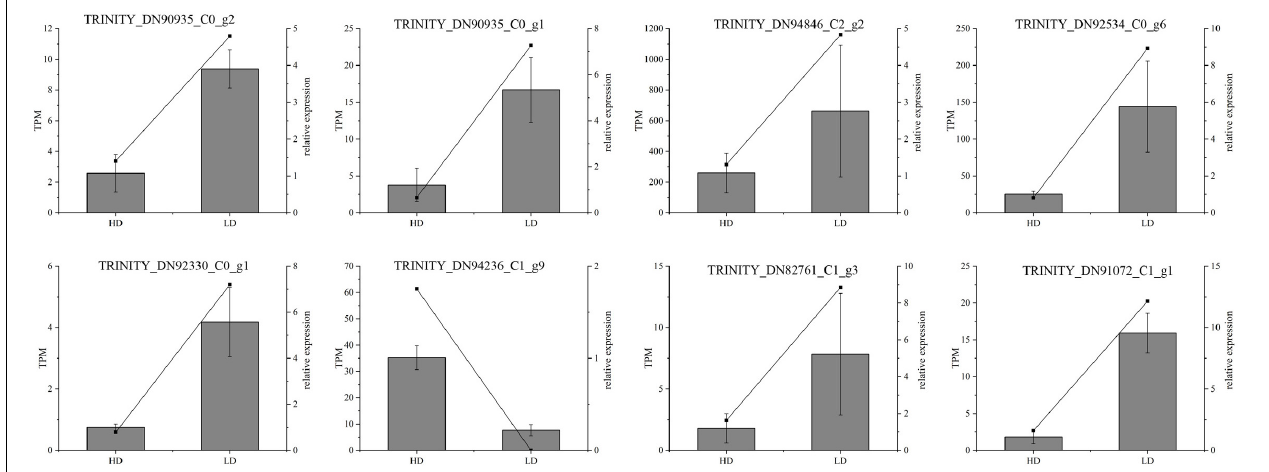
FIGURE 10 | Real-time quantitative polymerase chain reaction (RT-qPCR) validation of candidate unigenes involved in Cyclocarya paliurus phenolic acid biosynthesis. The histogram shows the relative gene expression obtained via RT-qPCR. The transcripts per million (TPM) of each million mapped fragments of the transcriptome are represented by a line graph. The right y -axis indicates gene expression levels calculated as TPM. The left y -axis indicates relative gene expression levels obtained via